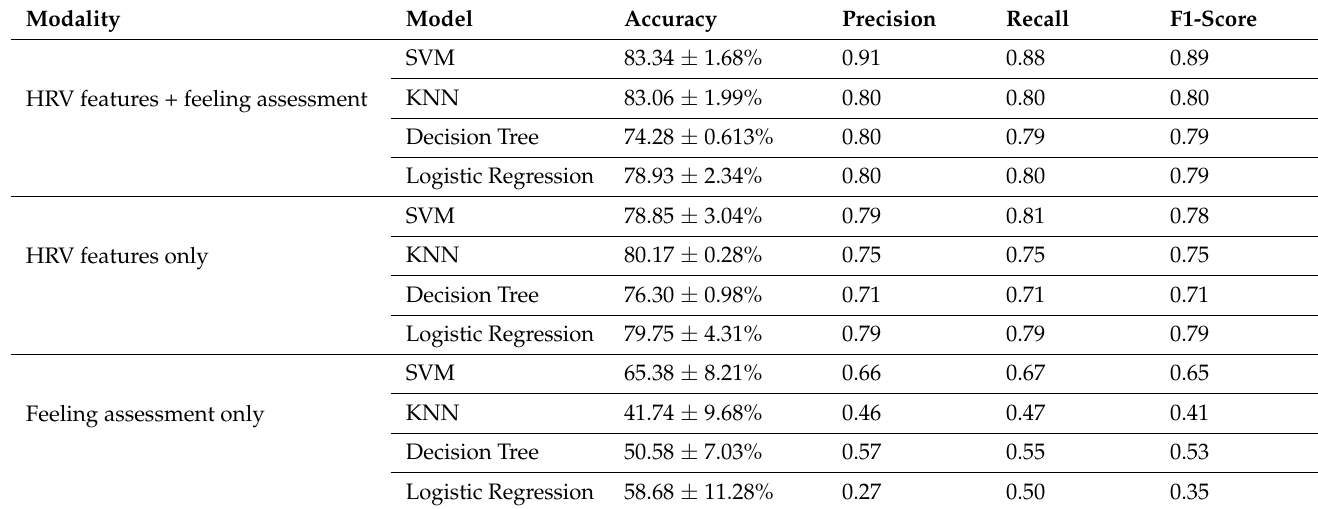
Table 2. Heart signals prediction results and performance—time window =